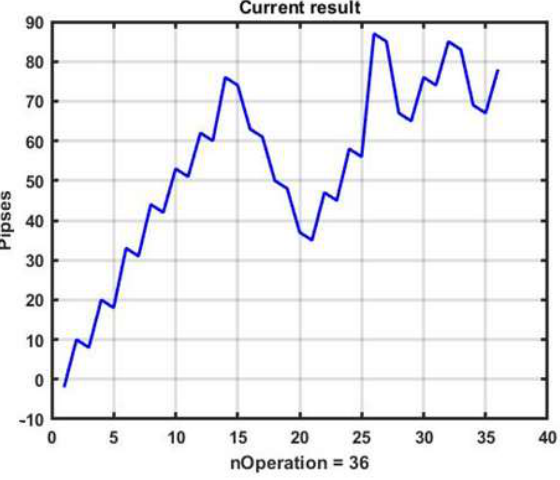
Figure 13. Example implementation of CSB with three optimized parameters.